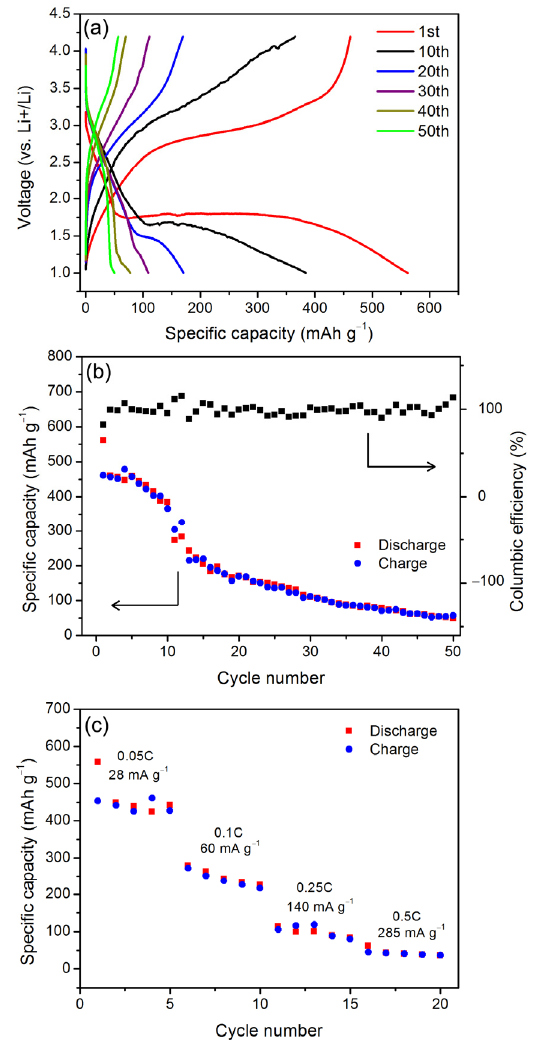
Figure 4. ( a ) 1st, 10th, 20th, 30th, 40th and 50th discharge–charge curves measured at a current rate of 20 mAh g − 1 between 1.0 V and 4.2 V (vs Li + /Li), ( b ) cycling performance and columbic efficiency (black squares), ( c ) rate performance under different current densities of FeF 2 nanomaterials.